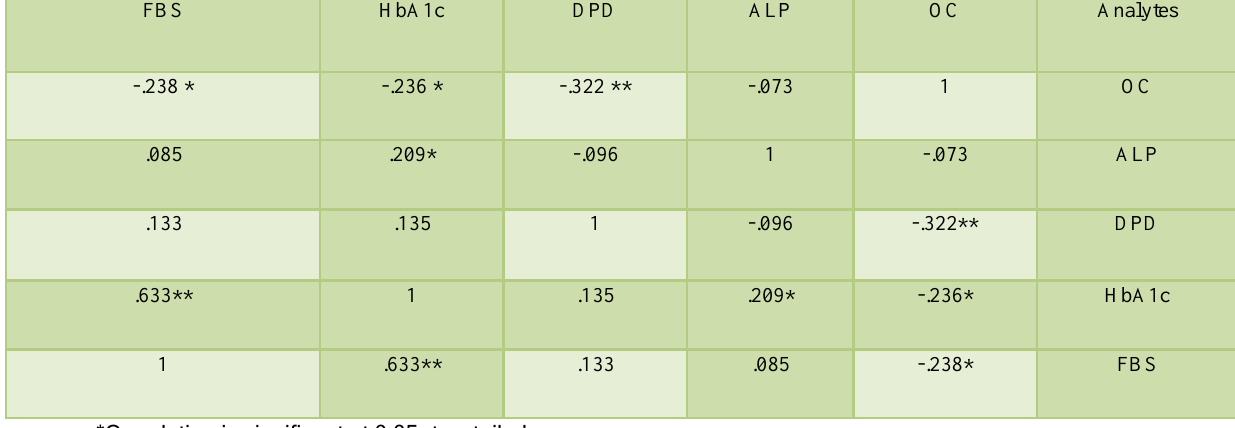
Table (1.4): The pearson correlation analysis among OC, ALP, DPD, HbA1c and FBS in diabetic patients